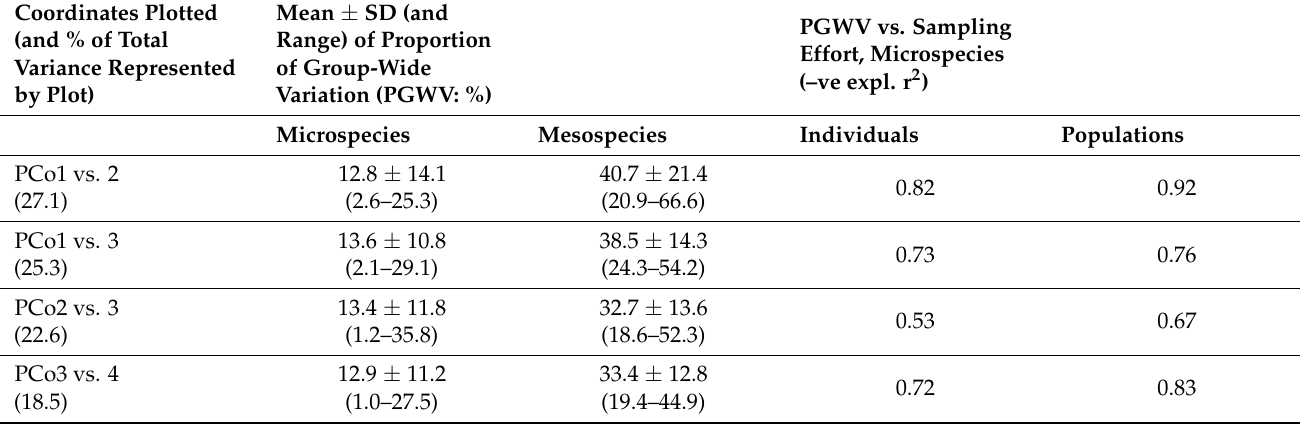
Table 2. Comparison of relative degrees, as measured via convex hulls, of congruence with (a) taxonomic circumscriptions of nine microspecies and five mesospecies and (b) sampling effort for microspecies at both the levels of individual plants and populations, in the three highest planes of vari- ation evident in the principal coordinates resulting from the morphometric analysis of macrospecies Fuciflora (see also Figure 16). r 2 was assessed against negative exponential curves for nine mi- crospecies, each represented by between five and 30